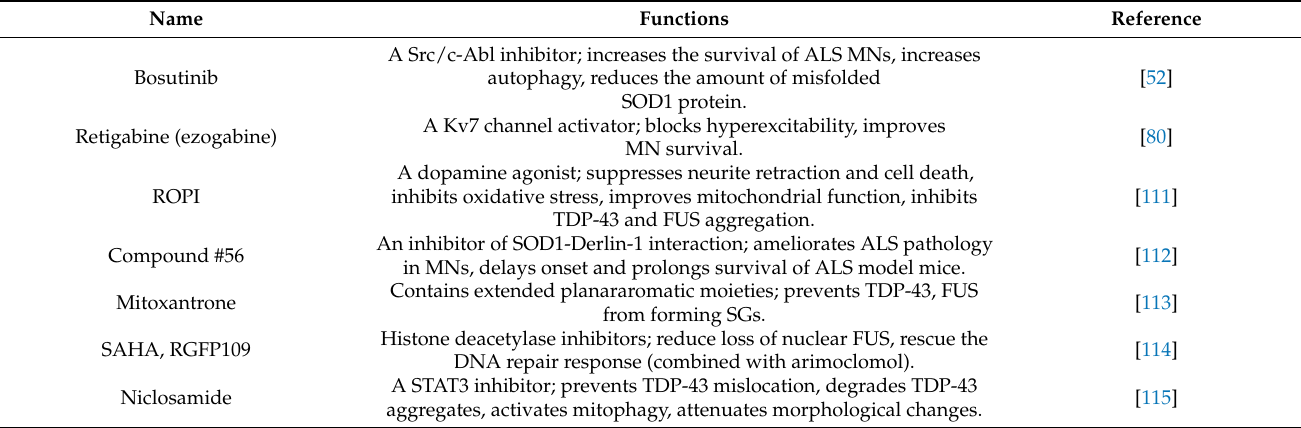
Table 2. Candidate drugs and compounds for ALS developed by iPSCs-disease